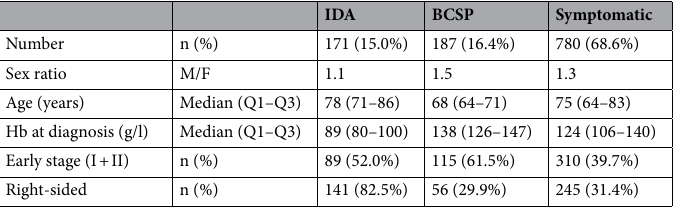
Table 1. Descriptive statistics of the CRC dataset divided by presentation pathway ( IDA iron deficiency anaemia, BCSP Bowel Cancer Screening Programme, and symptomatic